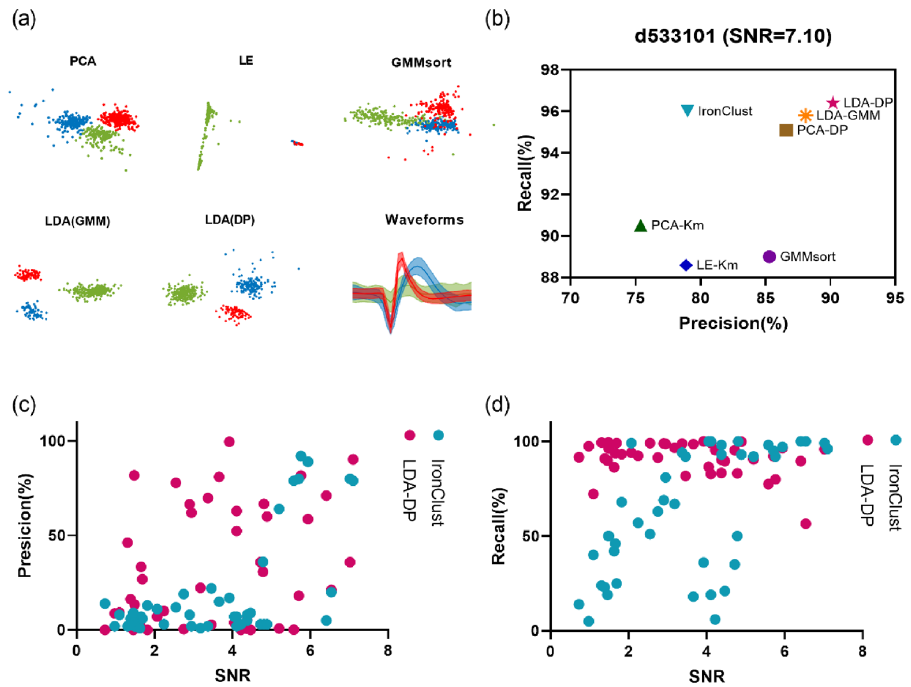
Figure 6. The sorting results on the in-vivo Dataset B when comparing 6 spike sorting algorithms. ( a ) Two- dimensional feature subspace extracted by each method. The data points are colored according to the sorting results, in which red, green and blue represent cluster 1, cluster 2 and cluster 3 respectively. The waveform panel shows the average spike waveforms of three clusters obtained by LDA-DP, and the shaded part represents the standard deviation. ( b ) The precision rate and the recall rate obtained according to partial ground truth on dataset d533101 in HC1. ( c , d ) The precision rate and recall rate comparison with regard to SNR on all the 43 datasets in Dataset